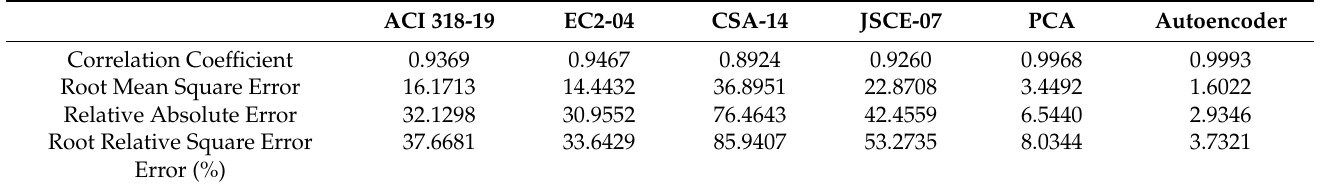
Table 2. Prediction